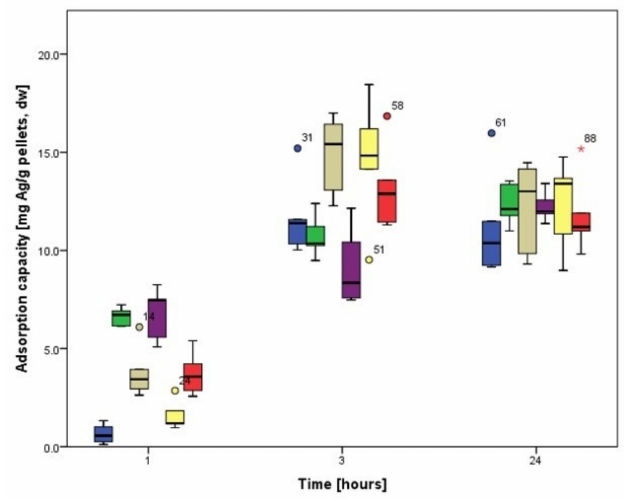
Figure 3. Ag adsorbed on Aspergillus tabacinus pellets at different pH values and contact times. pH: (cid:4) : 2; (cid:4) : 3; (cid:4) : 4; (cid:4) : 5; (cid:4) : 6; (cid:4) :